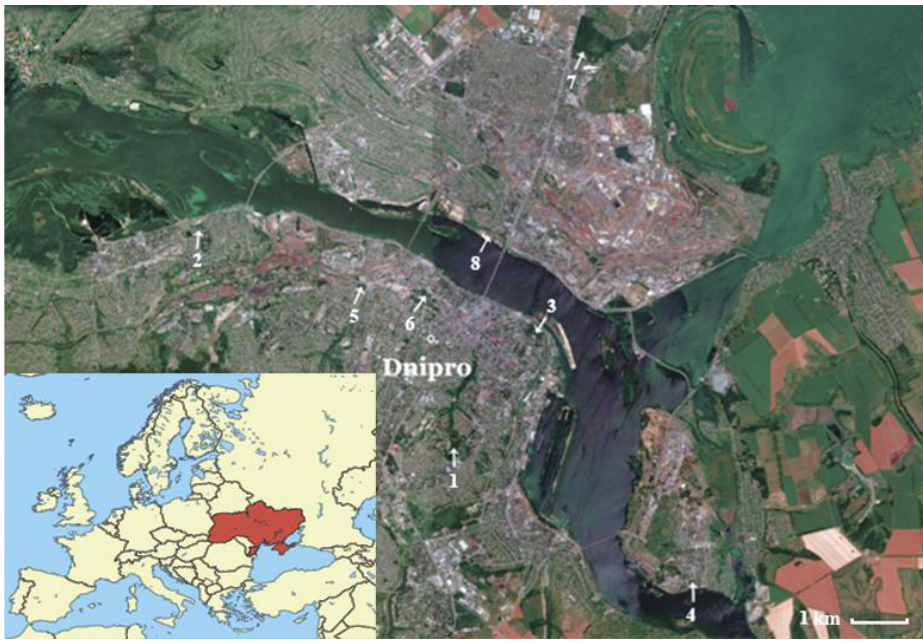
Figure 1 . Map of the sampling units within the territory of Dnipro city (Ukraine) . Figure 1. Map of the sampling units within the territory of Dnipro city